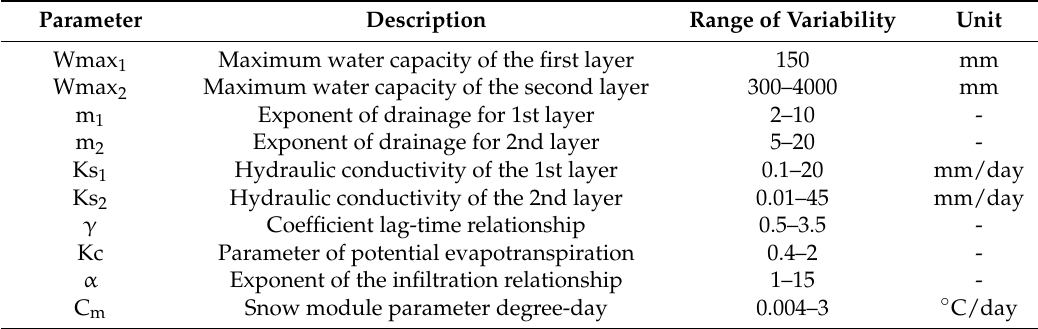
Table 2. List of the calibrated parameter of MISDc